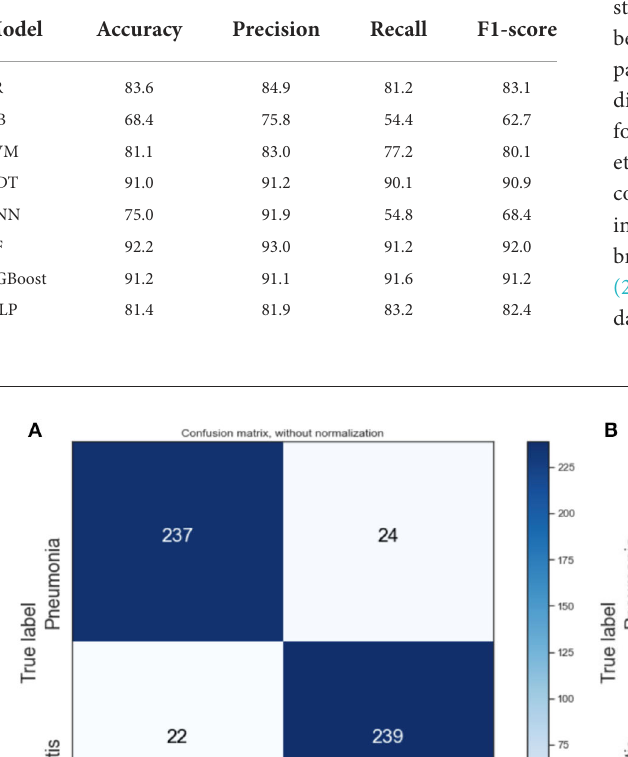
TABLE 5 Machine learning model prediction results in the balanced dataset.